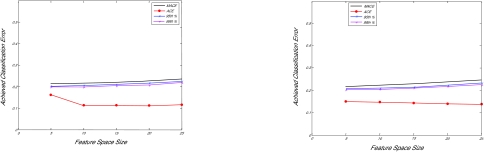
PACE analysis using a SVM-based classifier using the J5 scoring criterion, with a 0.6 MAC threshold. Left Panel: performance without peak selection. Right panel: performance with peak selection.